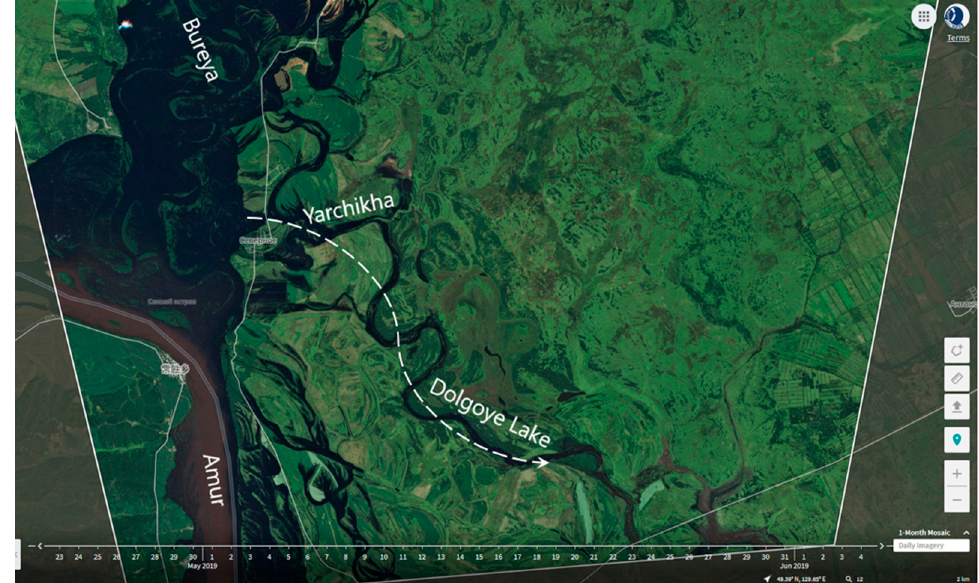
Figure 6. On 20 August 2013, the water of the Bureya River entered the Dolgoye Lake through the Yarchikha River, ensuring the hydrological connectivity of the Bureya River and its floodplain